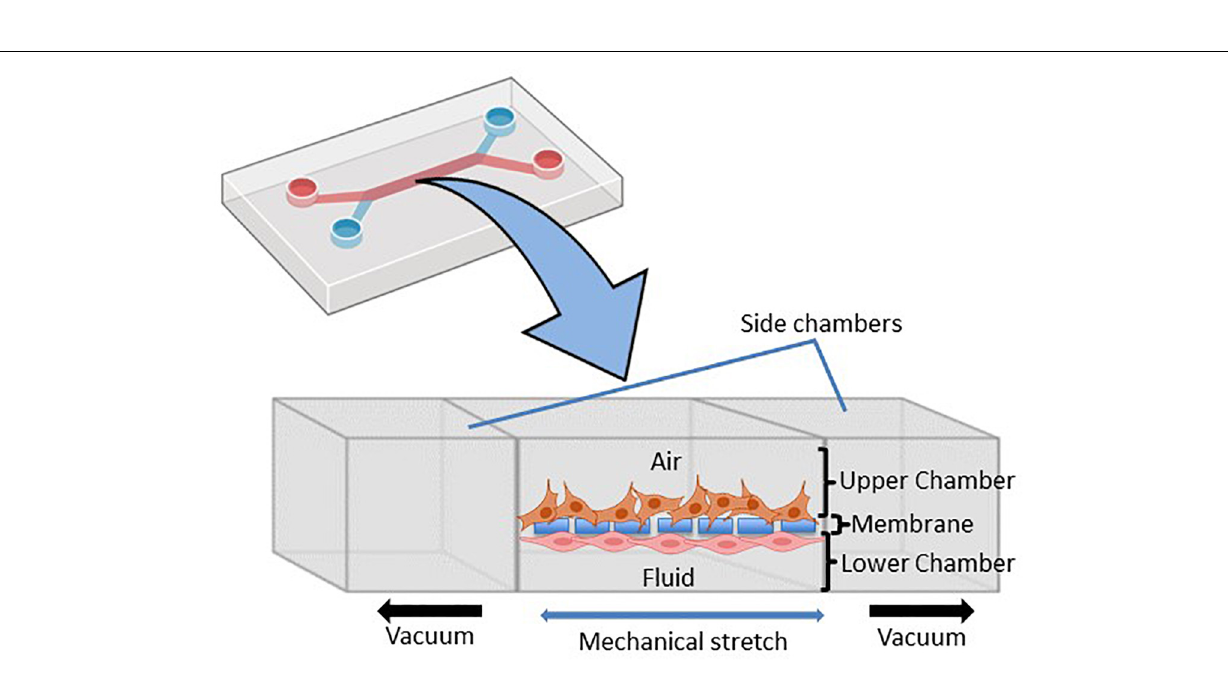
Frontiers in Bioengineering and Biotechnology | www.frontiersin.org